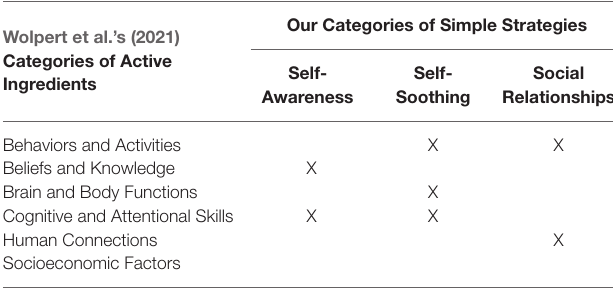
TABLE 1 | A crosswalk of our categories and Wolpert et al.’s (2021) categories of active ingredients. Wolpert et al.’s (2021) Categories of